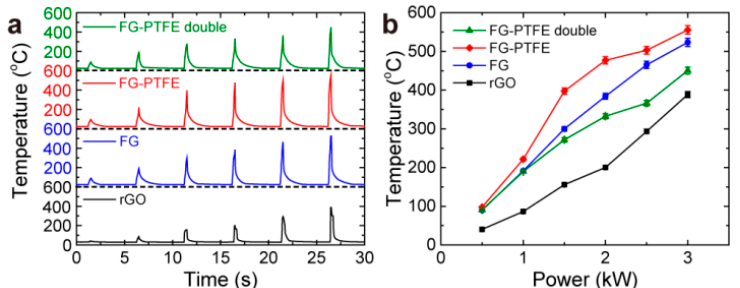
Figure 3. Results of the laser-induced, temperature-rise tests. ( a ) Temperature profiles when the laser pulse was applied. ( b ) Laser-induced temperature rise at different laser powers. The error bars were plotted according to the precision of the thermometer at each temperature.